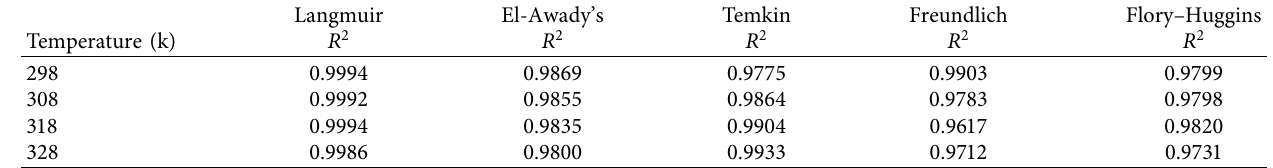
Table 2: Correlation coefficient values for the various adsorption isotherms considered.